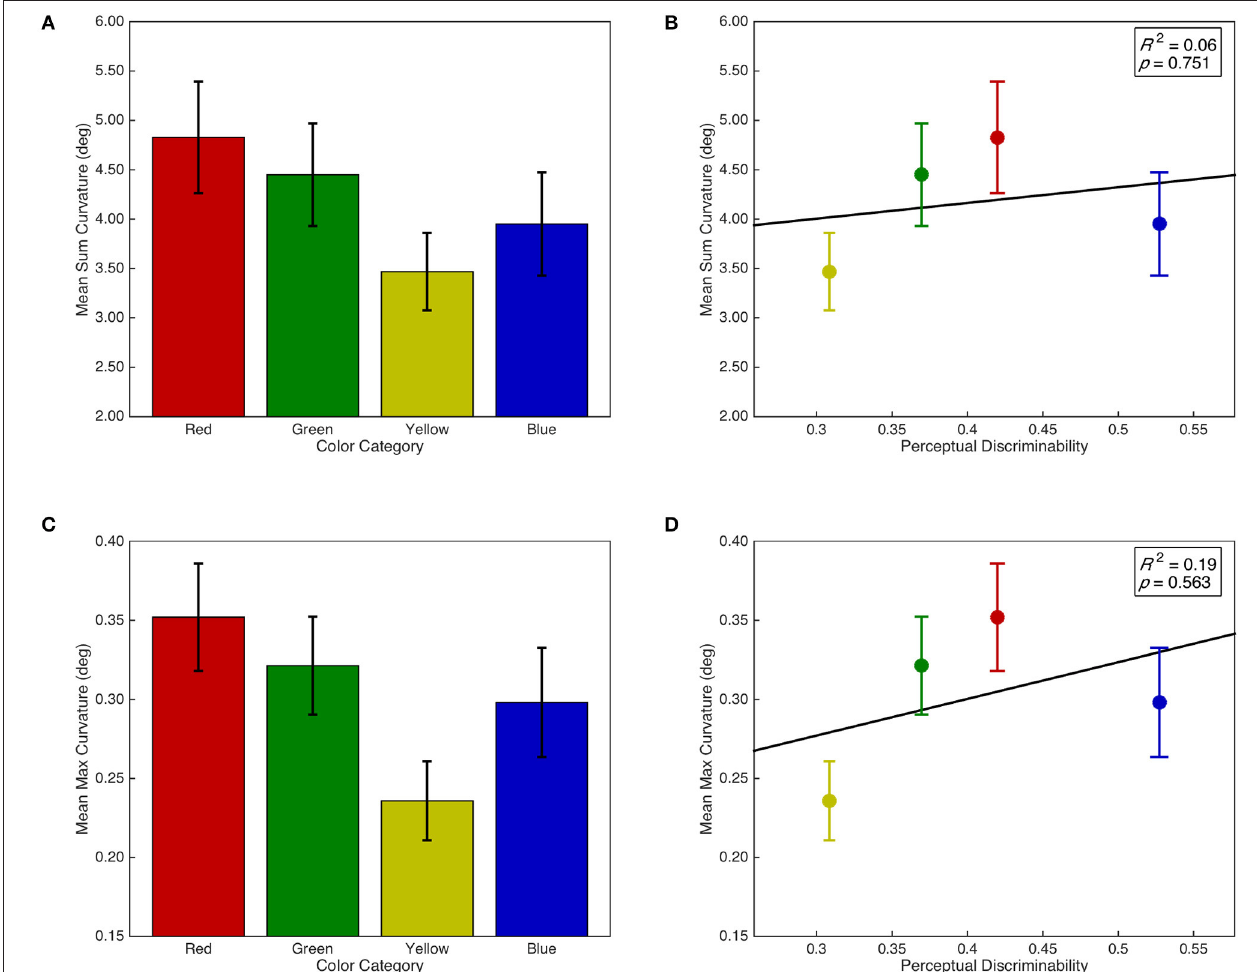
FIGURE 6 | Saccade curvature as a function of isolated distractor category and discriminability. Error bars represent standard error. Right panels include line of best fit, the coefficient of determination, and significance level from the regression analyses. (A) Sum curvature as a function of isolated distractor color category. (B) Sum curvature as a function of isolated distractor discriminability in CIE ( x , y ) color space. (C) Max curvature as a function of isolated distractor color category. (D) Max curvature as a function of isolated distractor discriminability in CIE ( x , y ) color space.